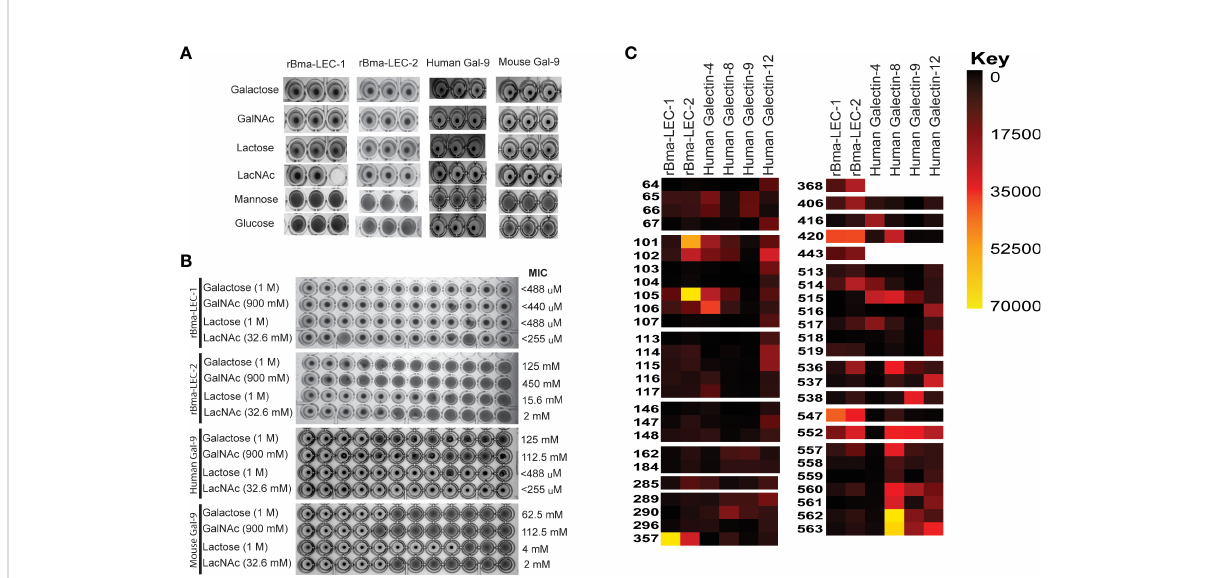
FIGURE 4 rBma-LEC-1/LEC-2 are functional homologs of mammalian galectin-9. (A) Hemagglutination inhibition (HI) assay was used to determine the carbohydrate binding speci fi cities of rBma-LEC-1 and rBma-LEC-2. A panel of common carbohydrates was used to test if the recombinant proteins were functional galectins. A solid colored well indicates that the galectin present is not binding to the carbohydrate of interest but is binding the erythrocytes instead forming a lattice of erythrocytes on the bottom of the well. A well with a dot in the center indicates that the galectin present is binding the carbohydrate of interest not the erythrocytes allowing them to sediment at the bottom of the well. Both recombinant proteins were capable of binding 1 M galactose, 900 mM GlcNAc, 1 M lactose, and 32.6 mM LacNAc, each known galectin substrates. A similar sugar-binding pro fi le was observed with human and mouse galectin-9. This representative image, from three distinct biological replicates, shows technical triplicates of each carbohydrate tested. (B) The binding sensitivity of galectins were analyzed by determining the minimal inhibitory concentration (MIC) of each carbohydrate solution. Two-fold serial dilutions of each carbohydrate were prepared in one row of a 96-well plate for each carbohydrate with the fi rst well starting at the concentration indicated. Wells with a dot in the center indicate that the galectin is able to bind that concentration of the carbohydrate of interest. The MIC is determined at the fi rst well where the galectin is no longer able to bind that concentration of carbohydrate as indicated by a solid colored well. rBma-LEC-1 had the highest af fi nity to all of the carbohydrate solutions tested and all galectins had the highest af fi nity to LacNAc. MIC are indicated at the end of the row. (C) A glycan binding array was used to compare rBma-LEC-1 and rBma-LEC-2 glycan binding pro fi les with those of human galectin -4, -8, -9 and -12 using a substrate of 584 glycan moieties. The glycan binding pro fi les of the parasite galectins are most similar to human galectin-8 and galectin-9. Glycan binding arrays are quanti fi ed by relative fl uorescence units (RFU).An abbreviated version of this array data is presented with a full analysis found in Supplemental Materials 3. A corresponding key of glycan names associated with the numerical IDs is provided in Supplemental Materials